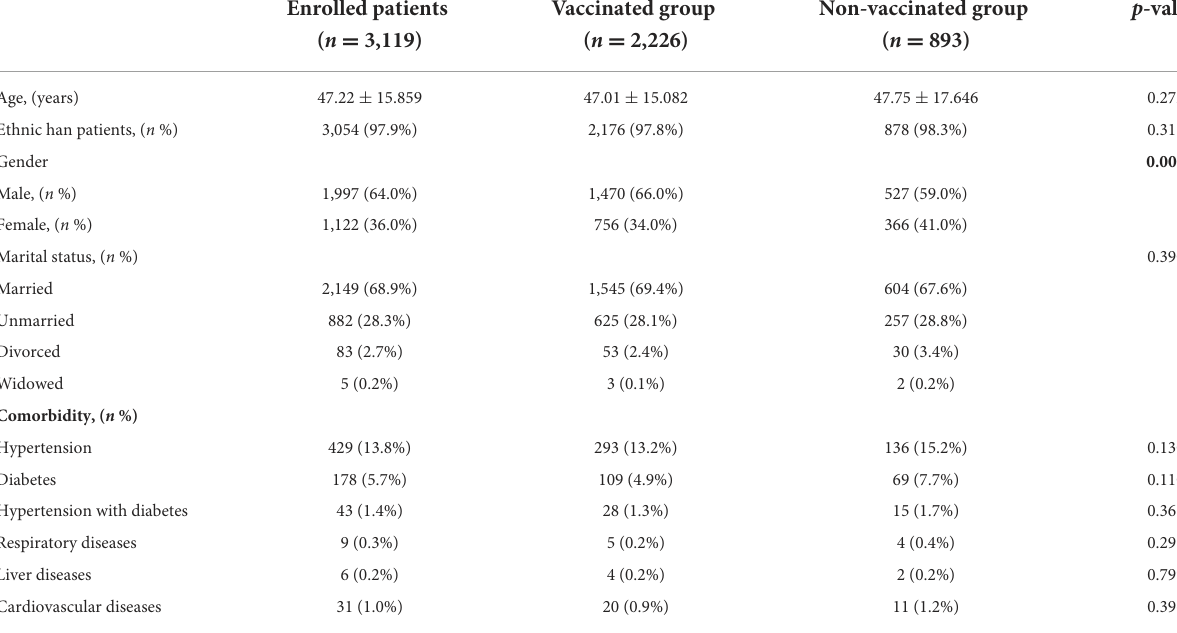
TABLE 1 Baseline characteristics of patients with SARS-CoV-2 infection ( n = 3,119).